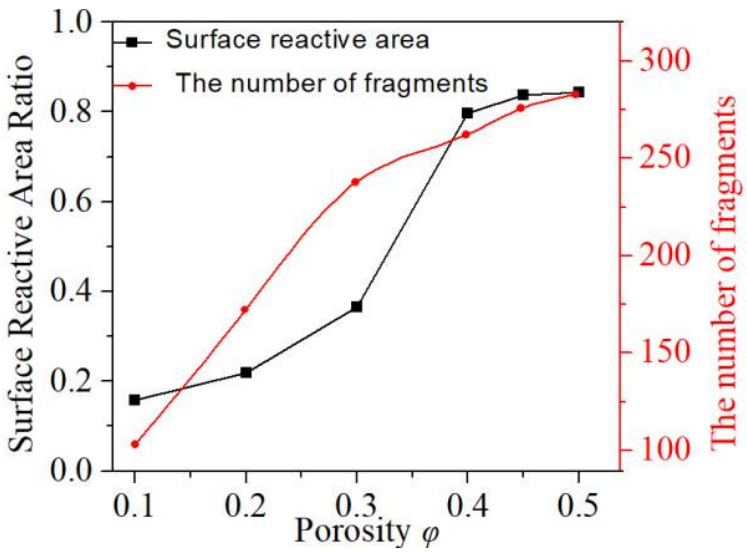
Figure 5. Surface reactive area and the number of fragments.